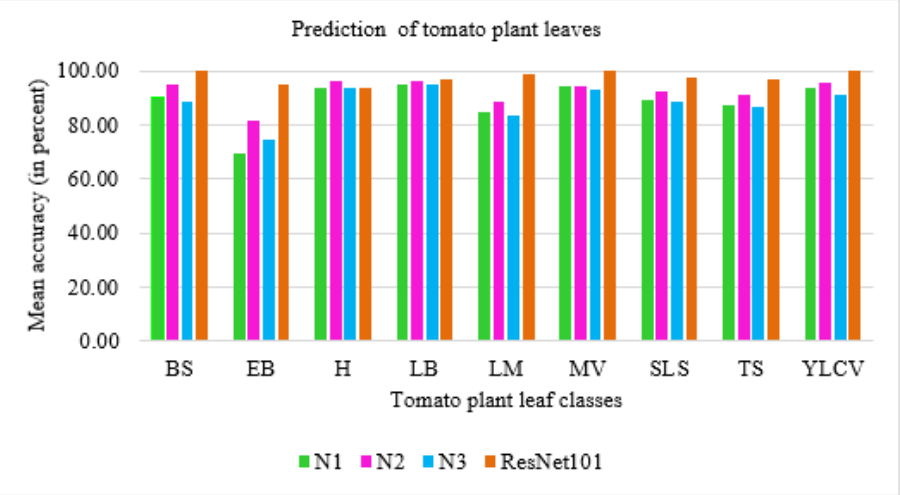
Figure 15. Predictions by N1, N2, N3, and ResNet-101 for PV data.